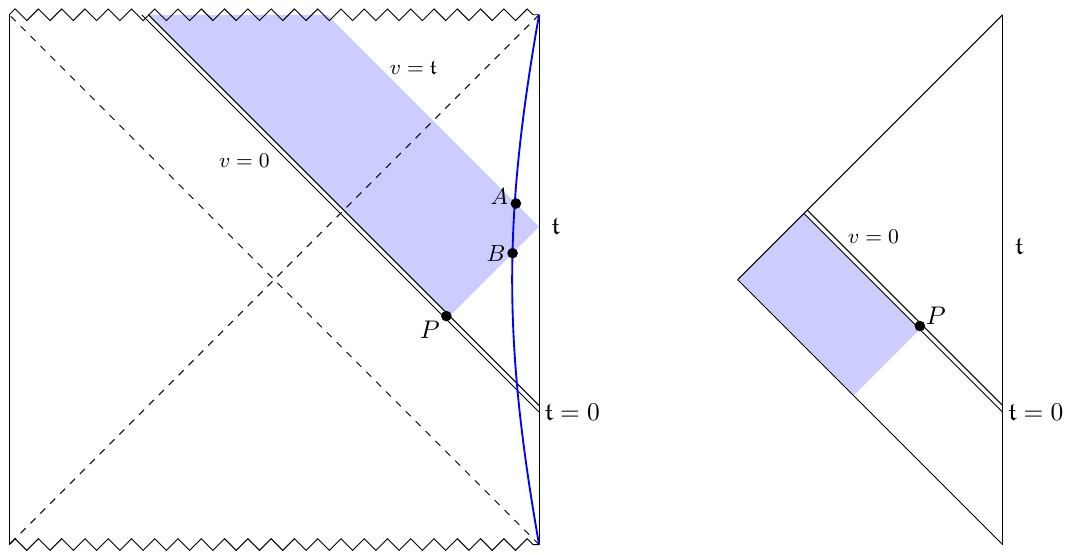
Figure 2 . The Penrose diagrams for AdS-Schwarzschild black hole (left) and vacuum AdS (right). The shaded region on the left/right corresponds to the part of the WdW inside/outside the collaps- ing null shell in (cid:12)gure 1. We have also included a cut-o(cid:11) surface at z = (cid:14) (shown as a blue line) in the Penrose diagram of AdS-Schwarzschild. The intersections of the WdW patch with the cut-o(cid:11) surface are labeled A and B , whereas the intersection of the past null boundary of the WdW patch and the collapsing null shell is denoted by a black dot and is labeled P